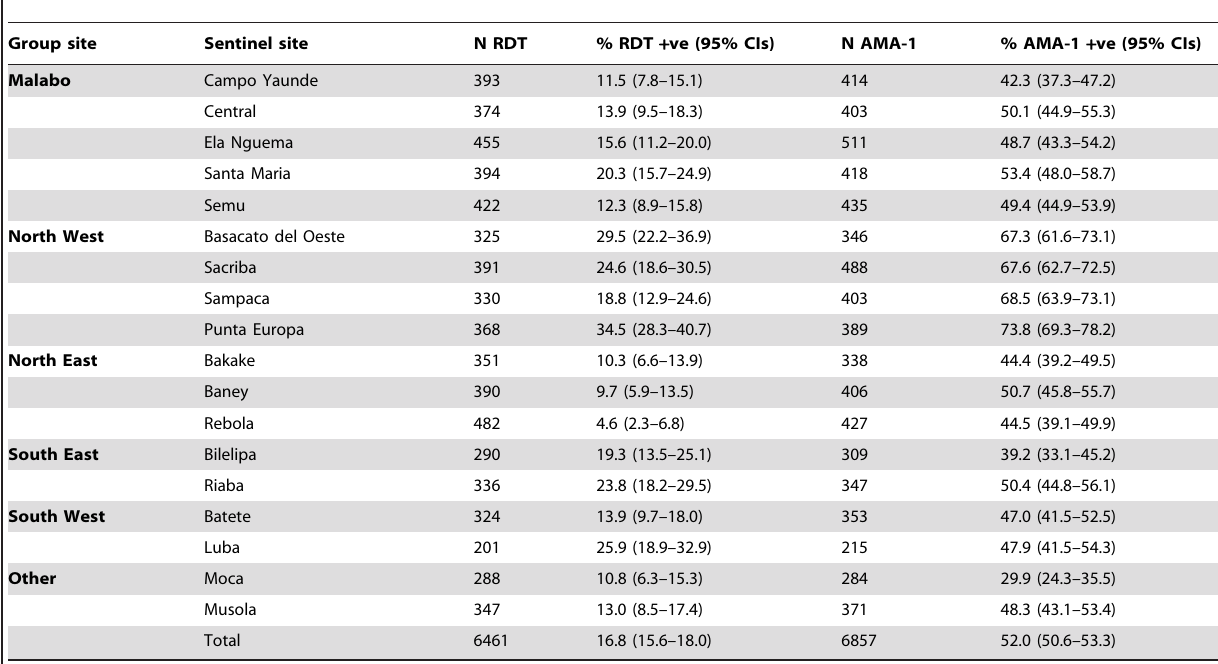
Table 2. Numbers and prevalence for Rapid Diagnostic Test and anti P.falciaprum AMA-1 antibody positive individuals for each sentinel site in